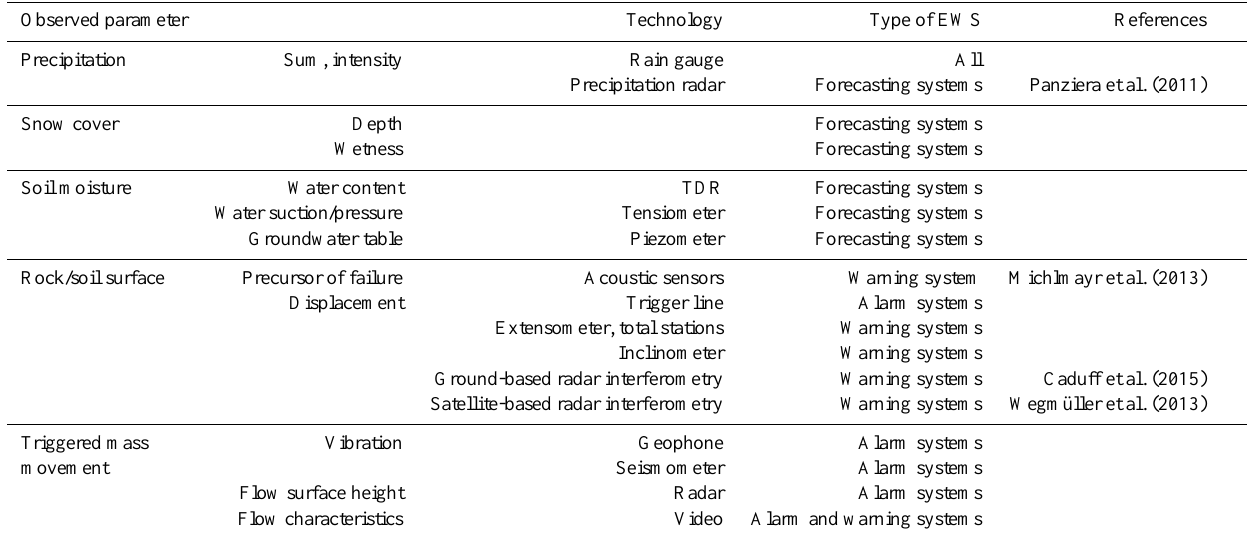
Table 1. Technologies typically used in current EWSs and proposed for future